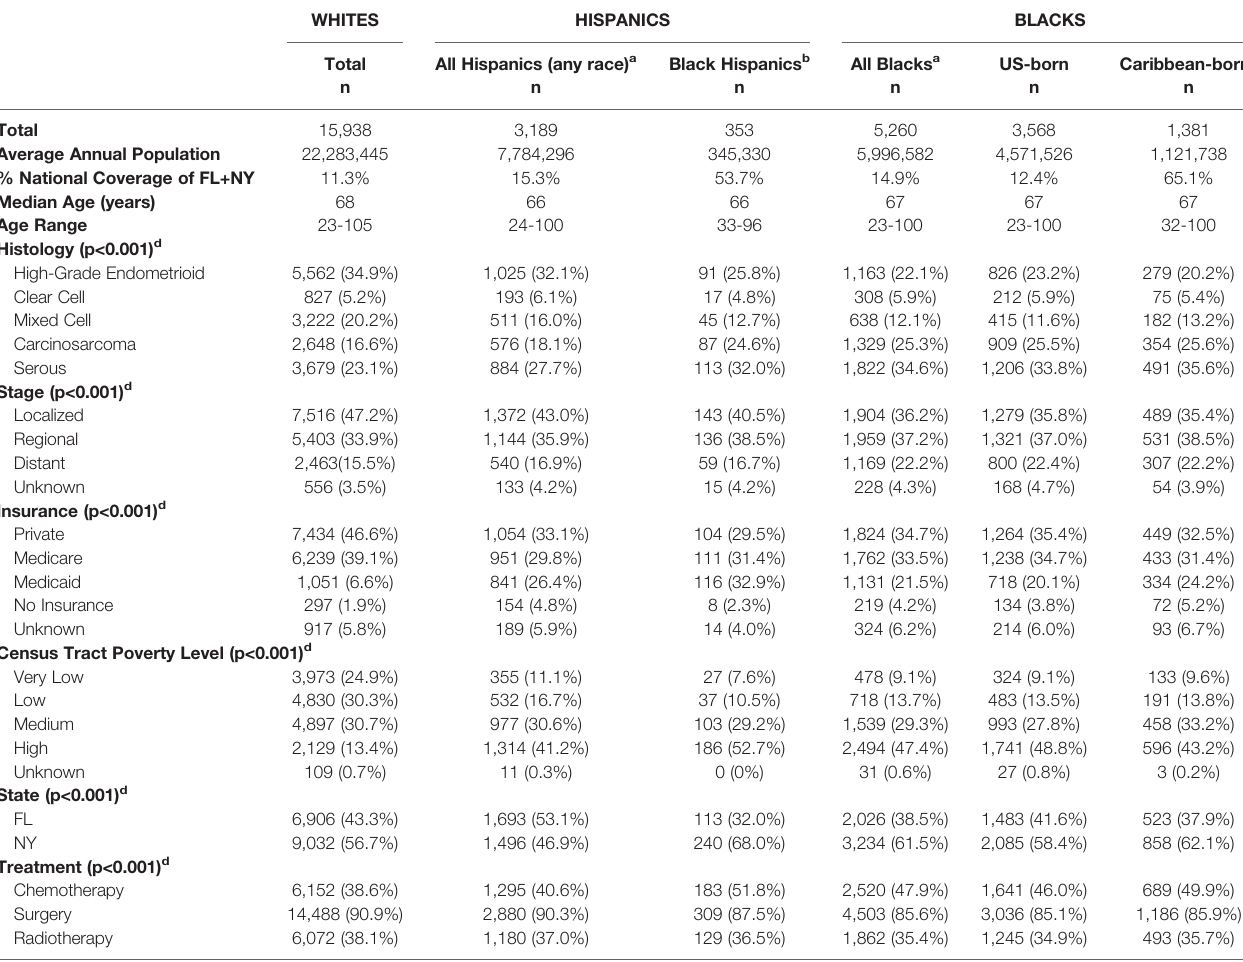
WHITES HISPANICS BLACKS Total All Hispanics (any race) a n